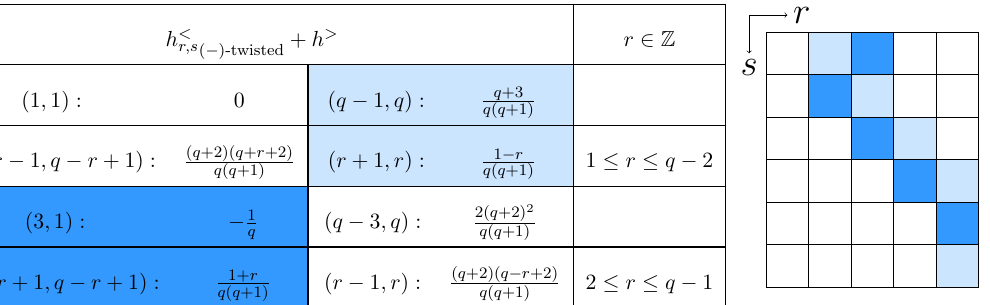
Table 3 . (+)-twist on special Neveu-Schwarz states. The numbers ( r; s ) in parenthesis determine the Coulomb gas representation used to calculate the weights after twist. One of the two possible representations (red and pink cells) is dimensionless after (+)-twist.